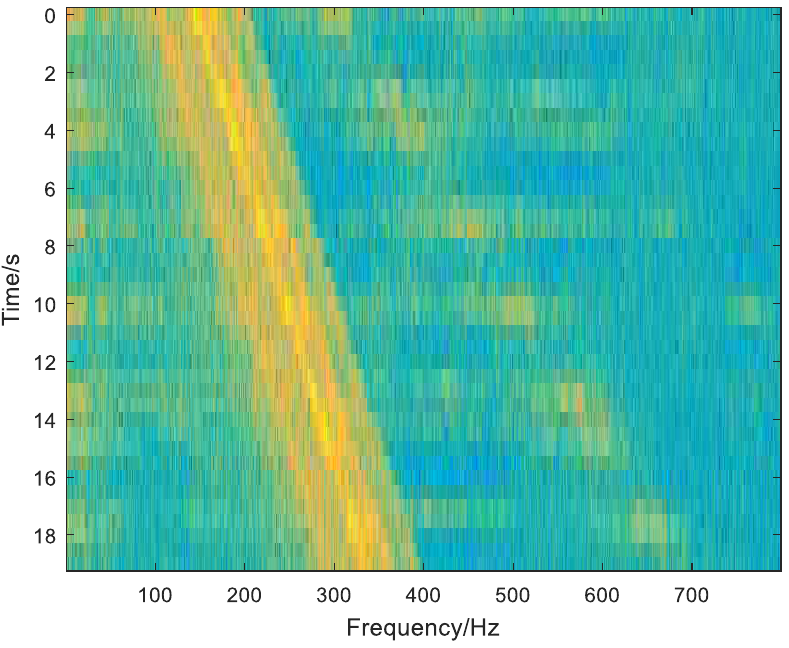
Figure 14. DEMON diagram of the receiving data. As the underwater target moved nonlinearly, the comparison results of the UKF method and the LSTM–Kalman filtering method, along with the real trajectory, are shown in Figure 15.